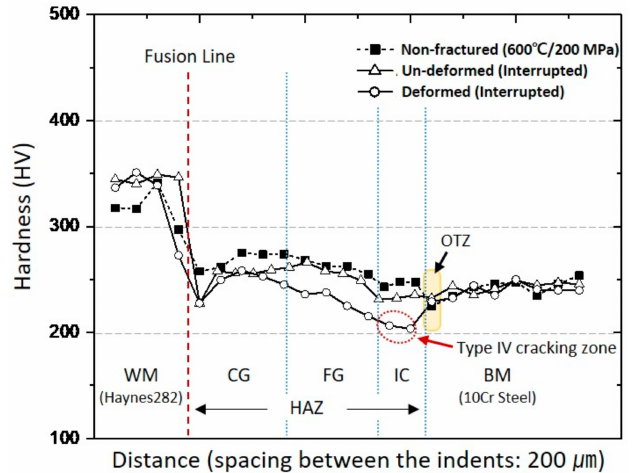
Figure 6. Hardness profile across the weldments in as-welded condition after creep interruption test at 630 ◦ C/150 MPa (including the hardness profile observed for the specimen crept at 600 ◦ C/200 MPa). After the creep test at 600 ◦ C/200 MPa, the detailed microstructural analysis of the ICHAZ (nonfractured side) in the as-welded specimen are shown in Figure 7. During welding, the ICHAZ region heated to a maximum temperature between A C1 and A C3 , and the original tempered martensite partially transformed to austenite upon heating which then transformed to fresh untempered martensite upon cooling [14,23,26,38]. Both newly transformed fine prior austenite grain boundaries (PAGBs) and former PAGBs decorated by a large number of precipitates were observed in the ICHAZ (Figure